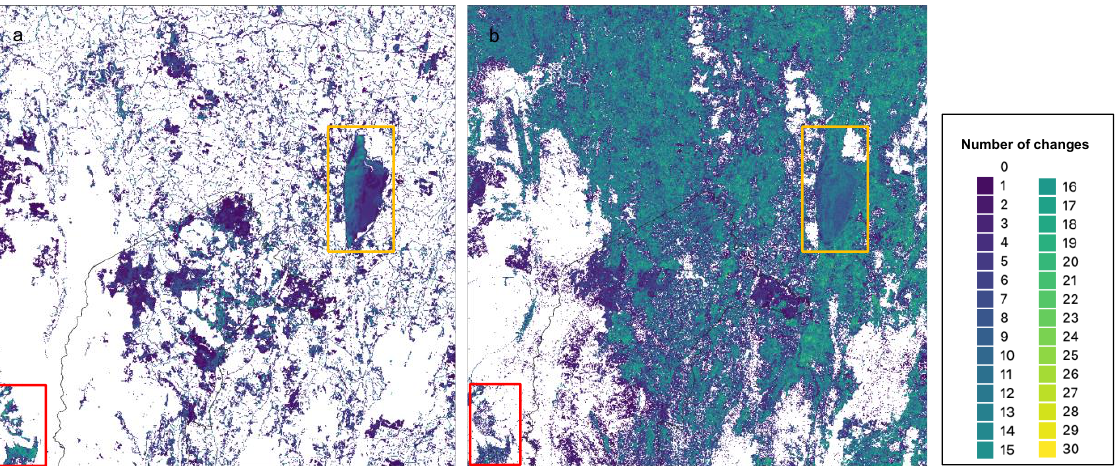
Figure 13. Total number of changes for simplified U-Net CNN model ( a ); maximum = 29, and simplified DEA Land Cover ( b ). Maximum = 30. Lake George (orange box) and southwest of tile (red box) highlighted.